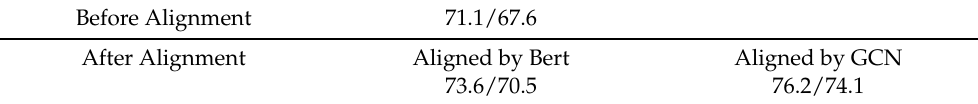
Table 4. MiF 1/ MaF 1 by ResNet-50 on MS-COCO (before and after alignment).